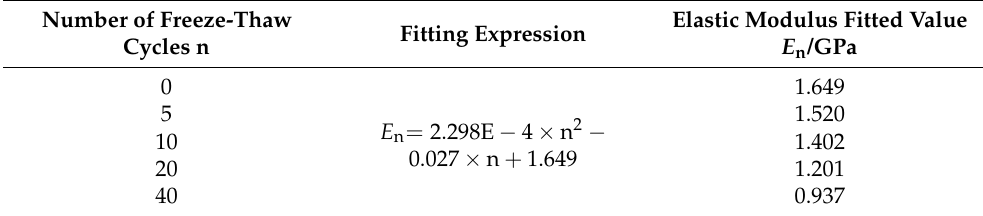
Table 7. Fitting values of elastic modulus of red sandstone under different freeze-thaw